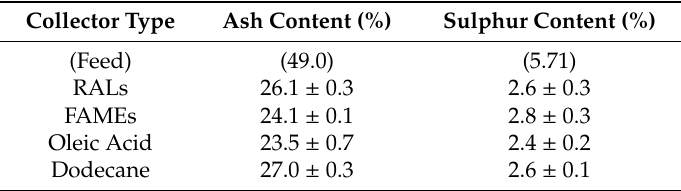
Table 1. Quality of coal recovered from Site 1 discards using RALs and FAMEs when compared to oleic acid and dodecane controls at a fixed dosage of 2.79 kg/t and at pH 2.7.